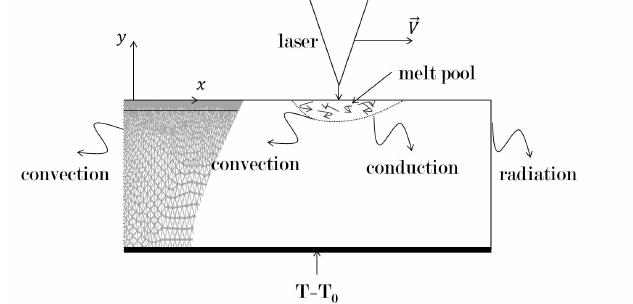
Figure 2. Representation of the mesh and of the numerical